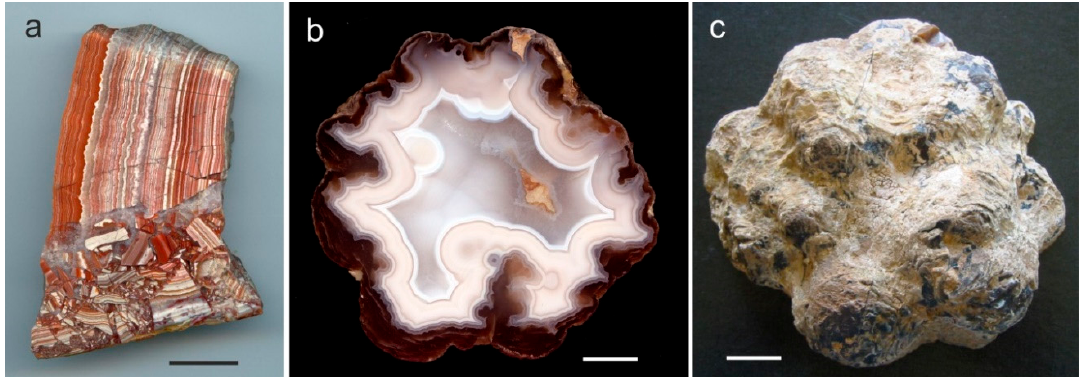
Figure 26. ( a ) Hydrothermal vein agate (“Trümmerachat”) from Schlottwitz, Saxony (Germany) showing brecciation and healing by secondary silicification in the lower part; primary agate formation took place in Permian time (263.7 ± 2.2 Ma), whereas brecciation and secondary cementation by silica happened much later during tectonic activities in the Upper Oligocene / Miocene [172]; ( b ) agate of sedimentary origin from Rutba, Western desert (Iraque); ( c ) back side of the agate in ( b ) illustrating the typical cauliflower-like surface; scale bar is 2 cm.